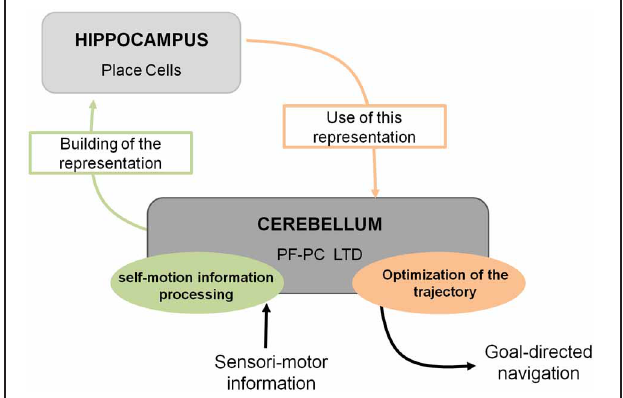
FIGURE 1 | Cerebello-hippocampal interaction for goal-directed navigation. The cerebellum contributes to spatial navigation at two levels, first in processing self-motion information to build spatial representation in the hippocampus at the level of place cells, and second in using this spatial representation to perform an optimal trajectory toward a goal. Studying L7-PKCI mice lacking LTD at PF–Purkinje cell synapses, this plasticity has been shown to be involved in both